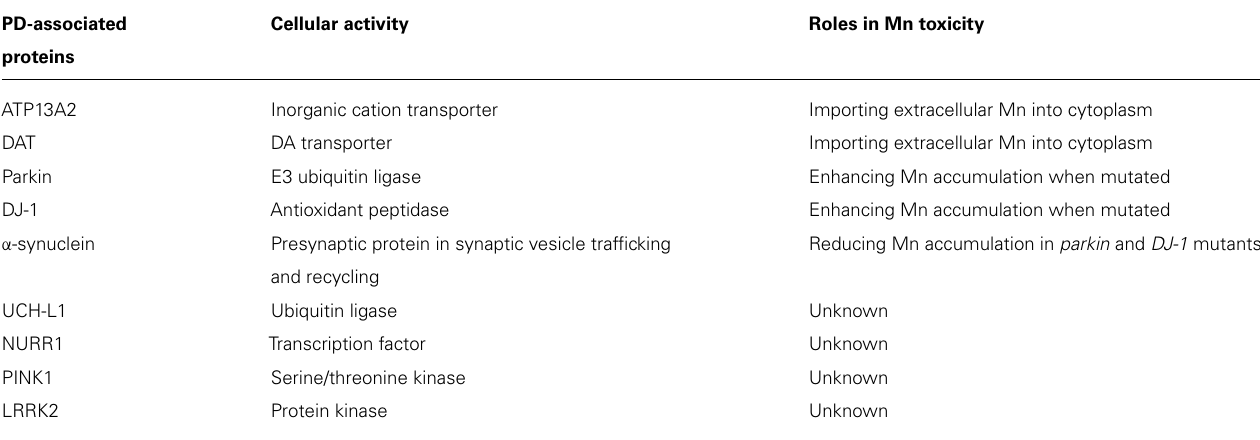
Table 2 | PD-associated proteins involved in Mn-induced